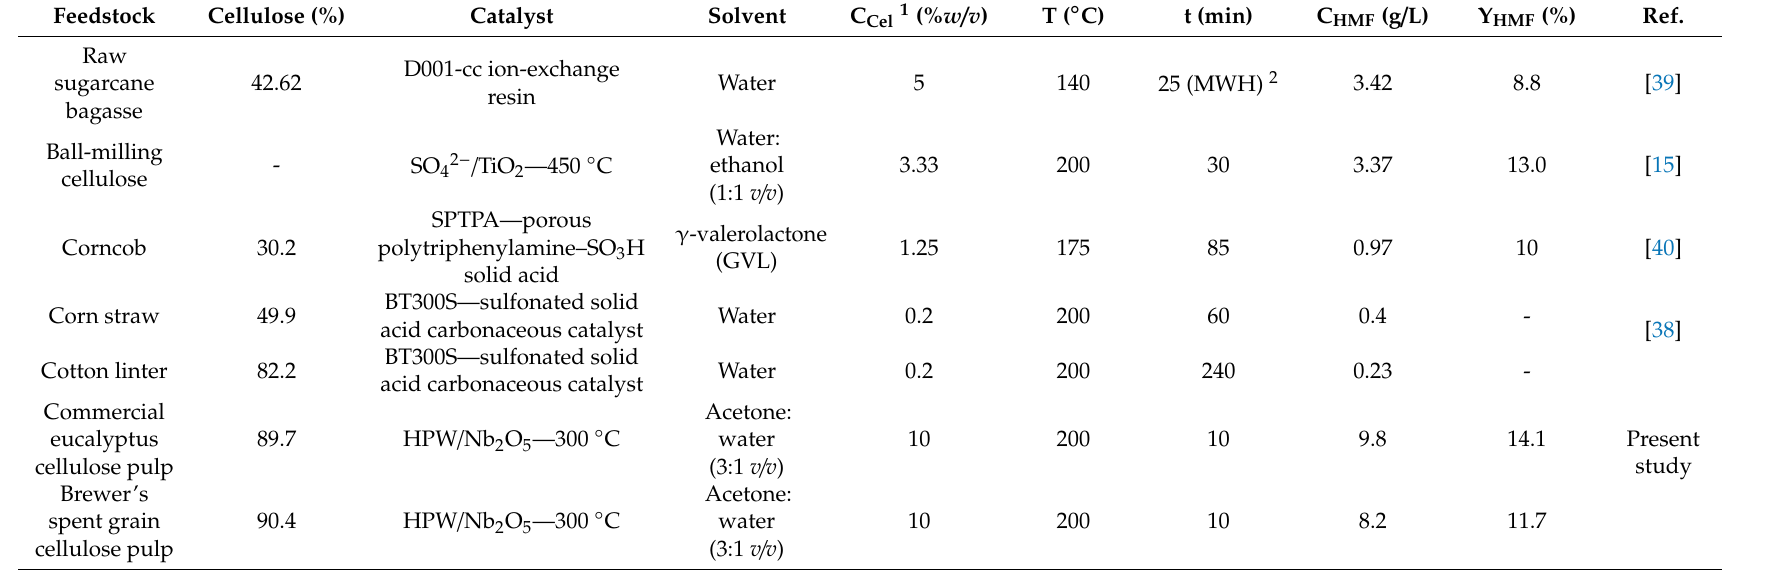
Table 8. Comparison of HMF production results carried out using feedstock from di ff erent sources of cellulose in the present study with a few recent studies reported in